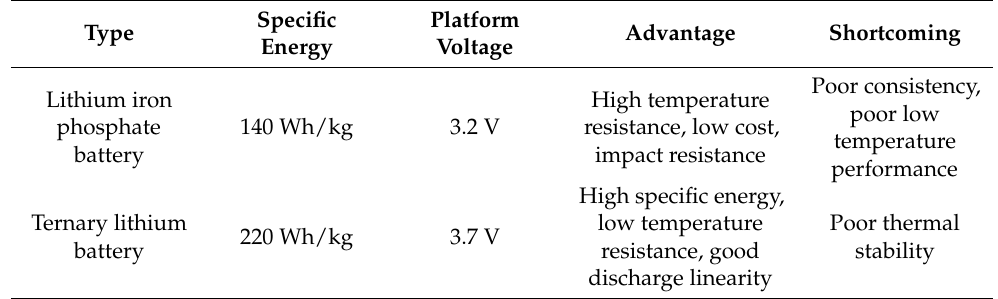
Table 1. Comparison of parameters between ternary lithium battery and lithium iron phosphate battery.